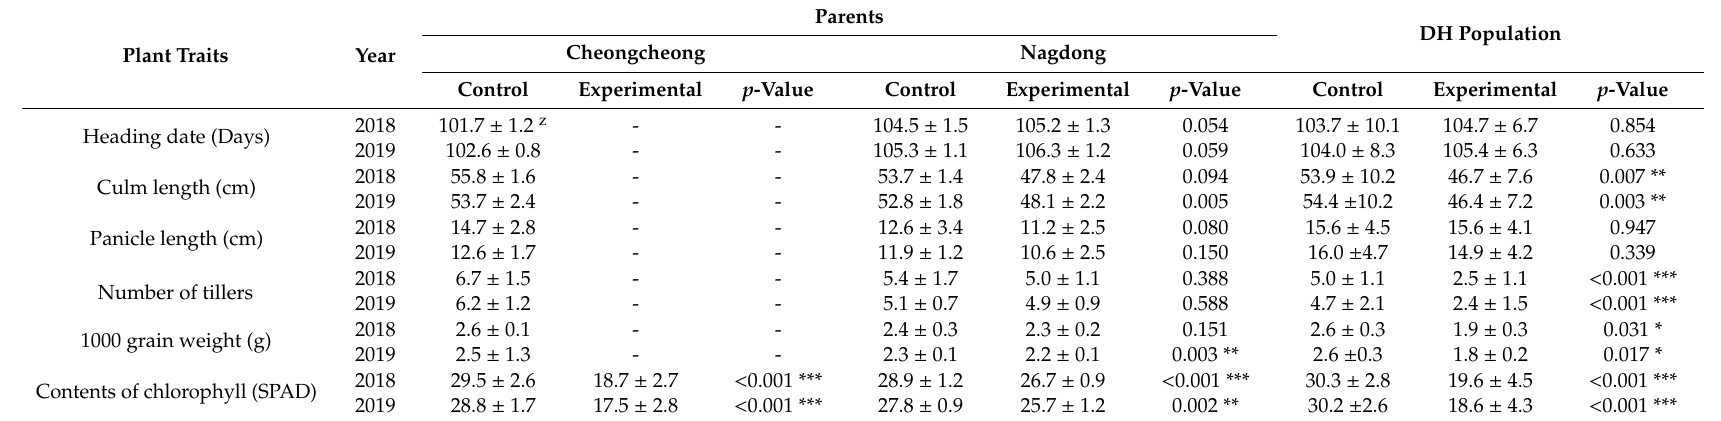
Table 1. Plant phenotypes of 120 Cheongcheong / Nagdong double haploid (CNDH) lines from a cross of the Cheongcheong and Nagdong